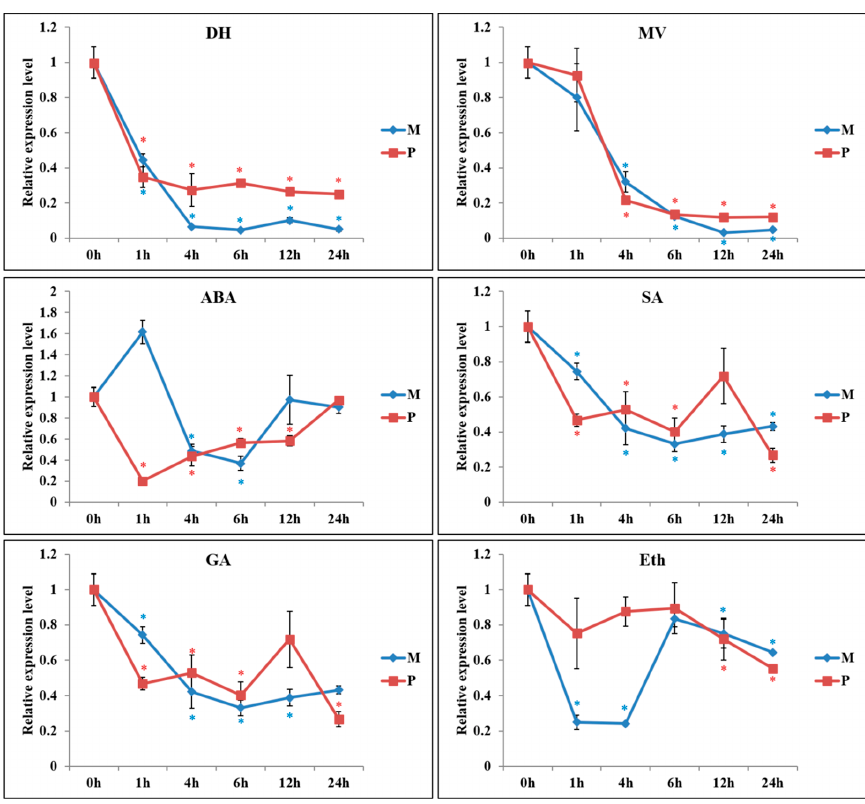
Figure 4. Expression pattern of tomato PKE1 under drought dehydration (DH), methyl viologen (MV), ABA (Abscisic acid), gibberellic acid (GA 3 ), SA (salicylic acid), ethephon (Eth; an ethylene releaser) treatment in S. lycopersicum cv. M82 (M) and Solanum pennellii LA0716 (P). All samples were collected at the time points (‘h’ refers to hours) after treatment from three biological replicates of each treatment. Data shown are means ± SE ( n = 3) *, Means differ p < 0.05.